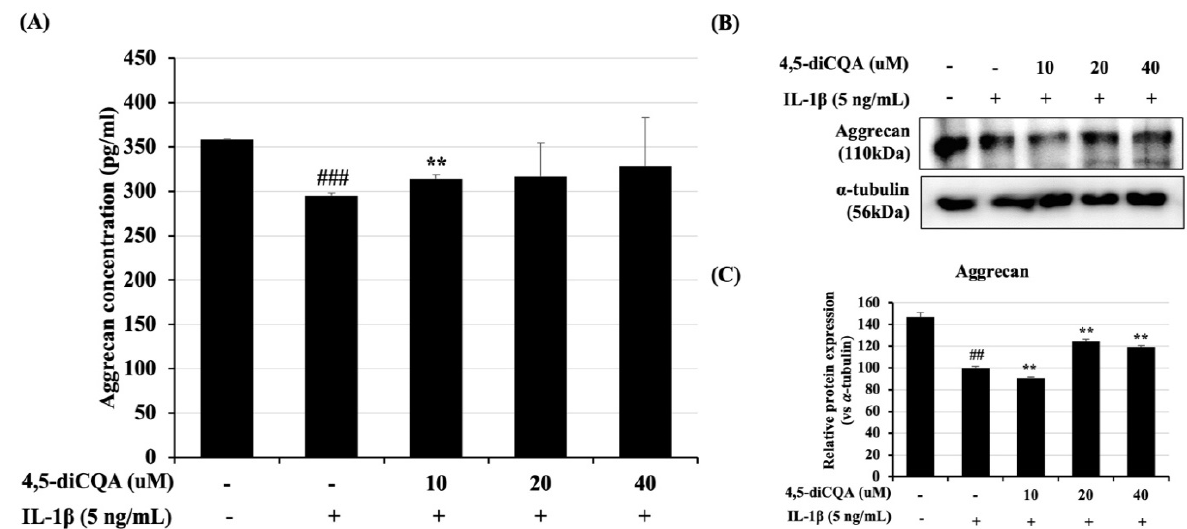
Figure 4. Inhibitory effect of 4,5 ‐ diCQA on IL ‐ 1 β‐ induced ACAN degradation in rat primary chon ‐